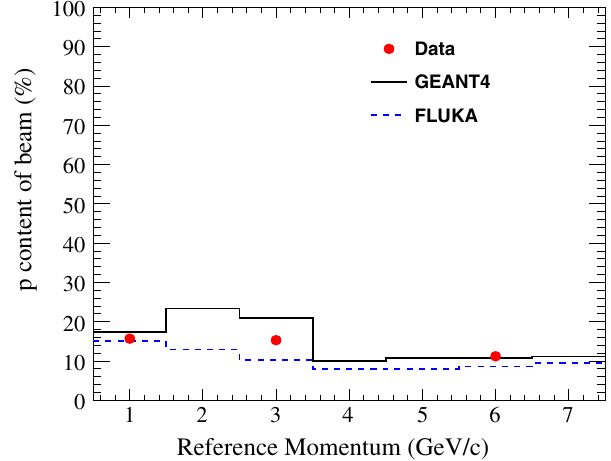
FIG. 24. Measured and simulated beam content for protons. A very good agreement between measurements and simulations is also